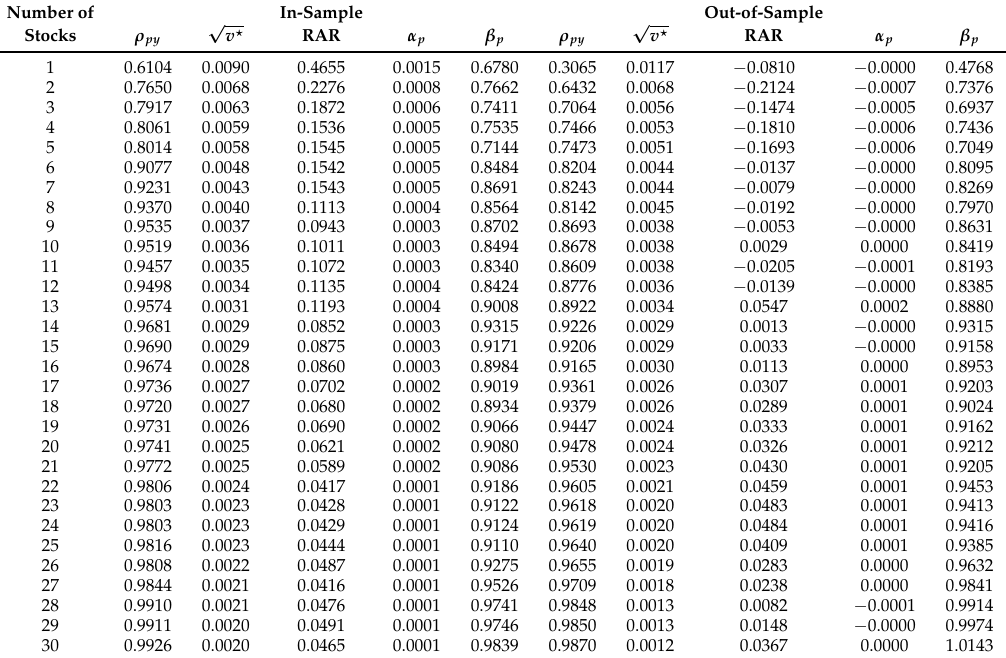
Table 7. Optimal tracking portfolios for DJIA index: Algorithm